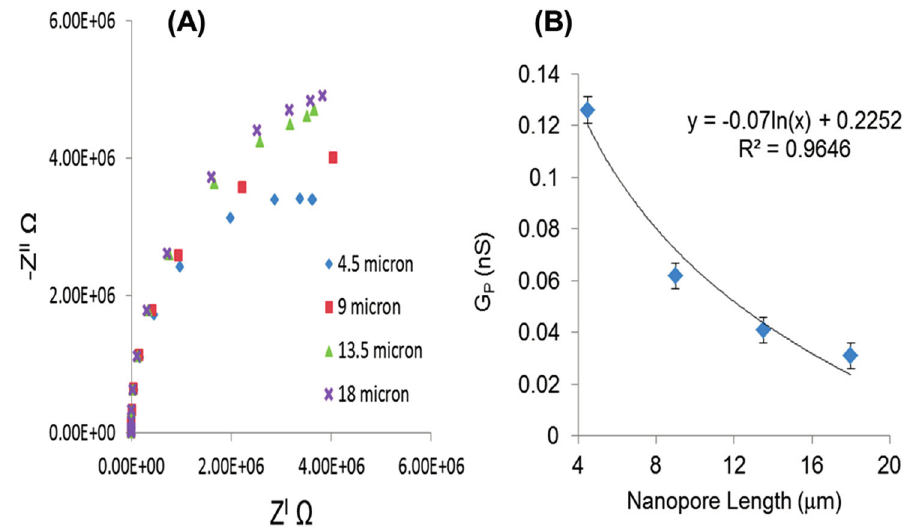
Figure 5. ( A ) At constant pore diameter (25 nm) and concentration (1 μ Μ ) four different pore lengths shows the increase in pore resistance R p with increased pore length ( B ) change in electric conductance (G p ) with respect to nanopore